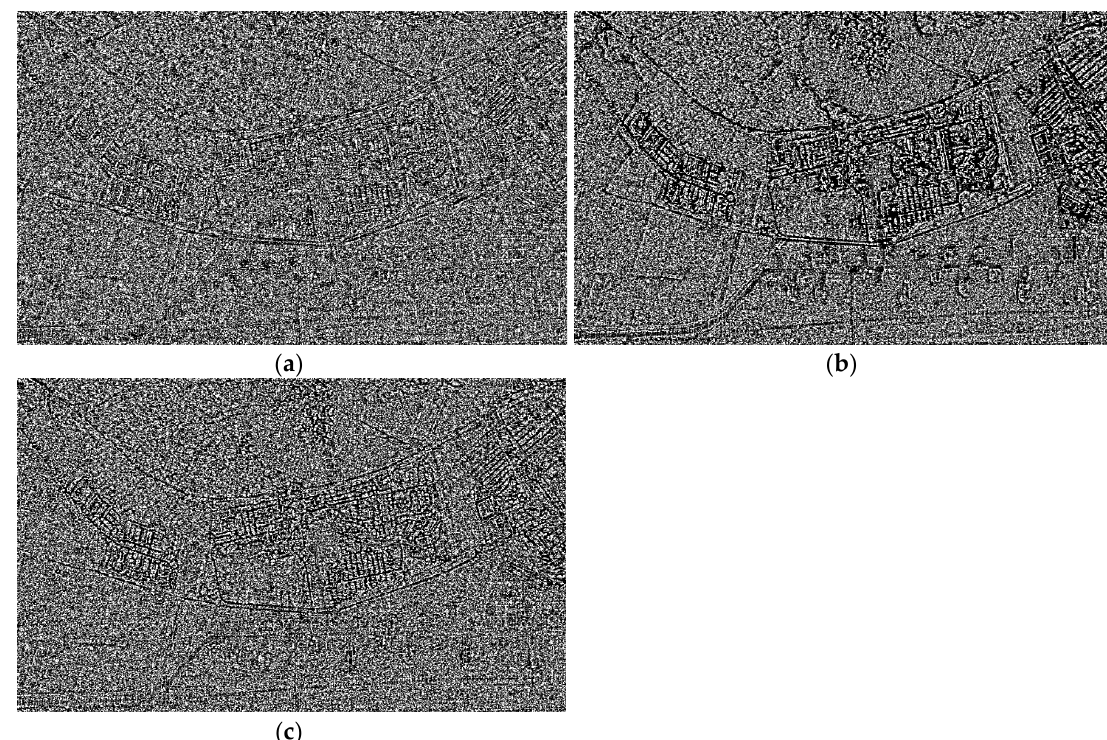
Figure 9. The ratio images of the different superpixel segmentation algorithms for the ESAR PolSAR image: ( a ) GMS segmentation, with N r = 7449; ( b ) Ncut segmentation, with N r = 8064; and, ( c ) SLIC-GC segmentation, with N r = 7728. Table 3. Means and variances of the ratio images for the different superpixel segmentation algorithms with the ESAR image.